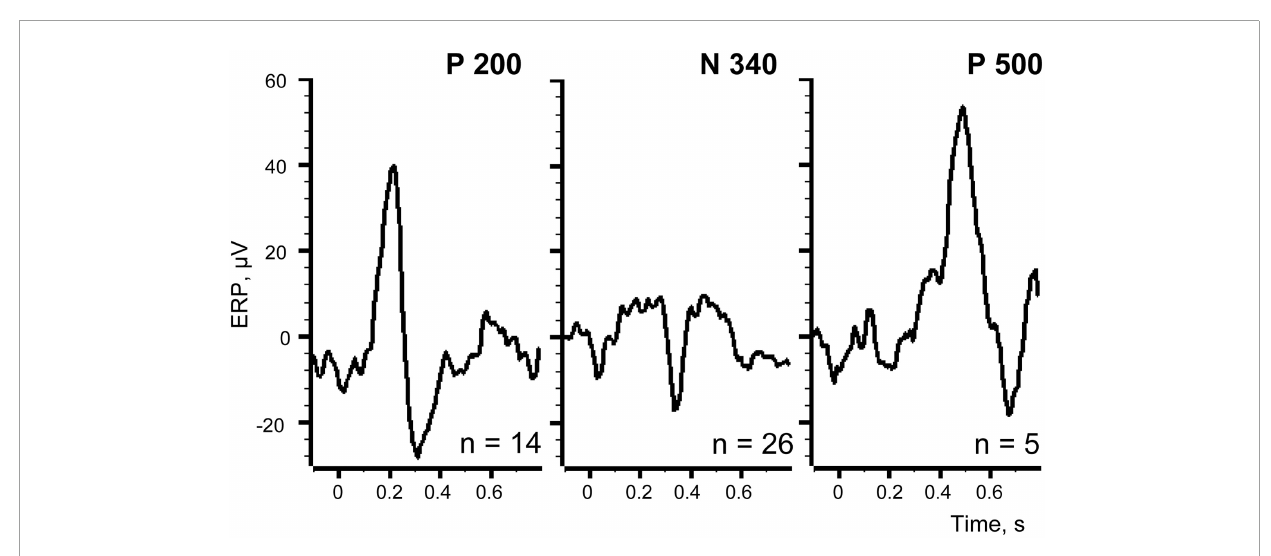
FIGURE9 Averaged evoked responses for the trials where each of the components appeared alone.